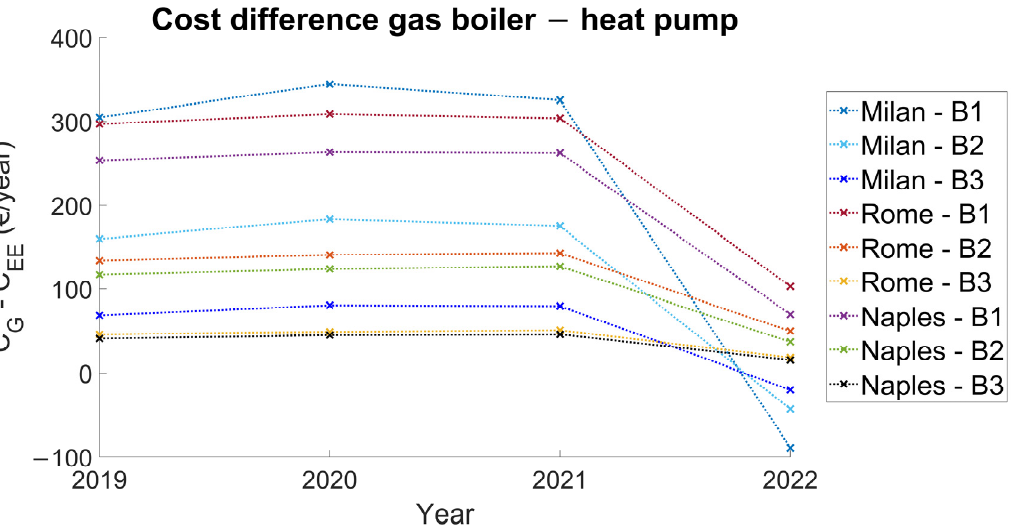
Figure 8. Yearly cost difference between gas boiler and heat pump; the figure refers only for cases in S1.